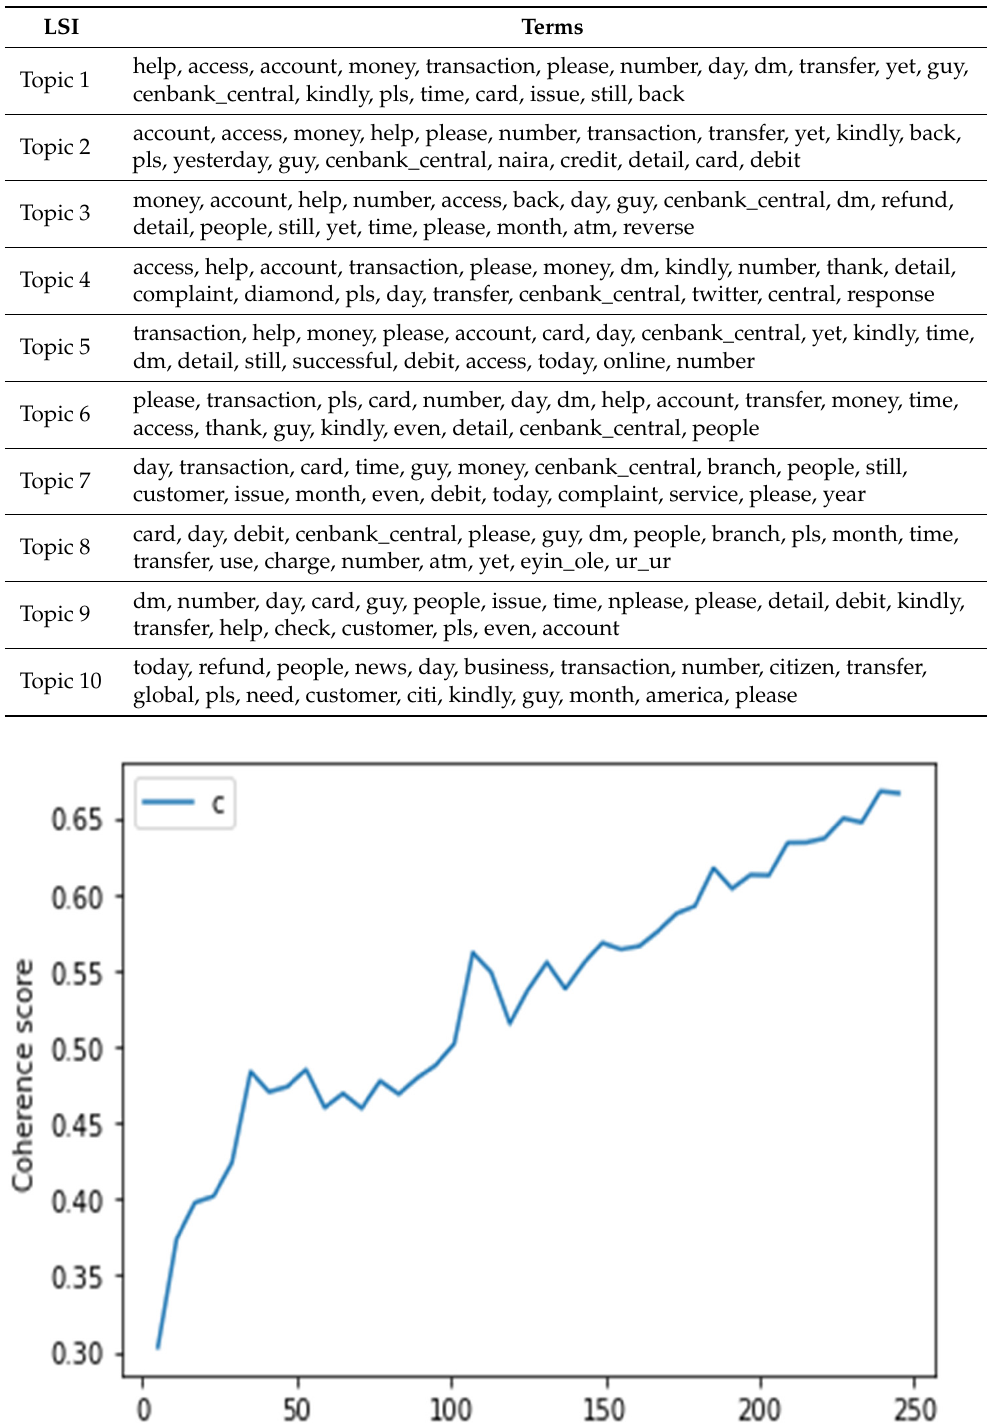
Table 6. LSI Topics.